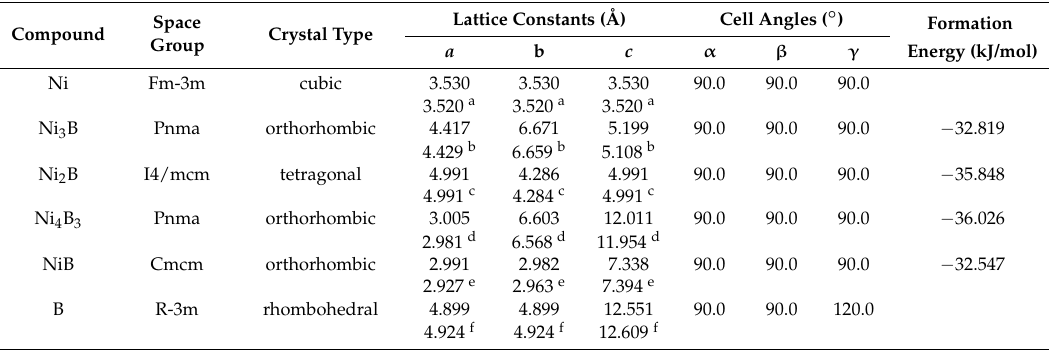
Table 1. The optimized parameters of Ni x B y